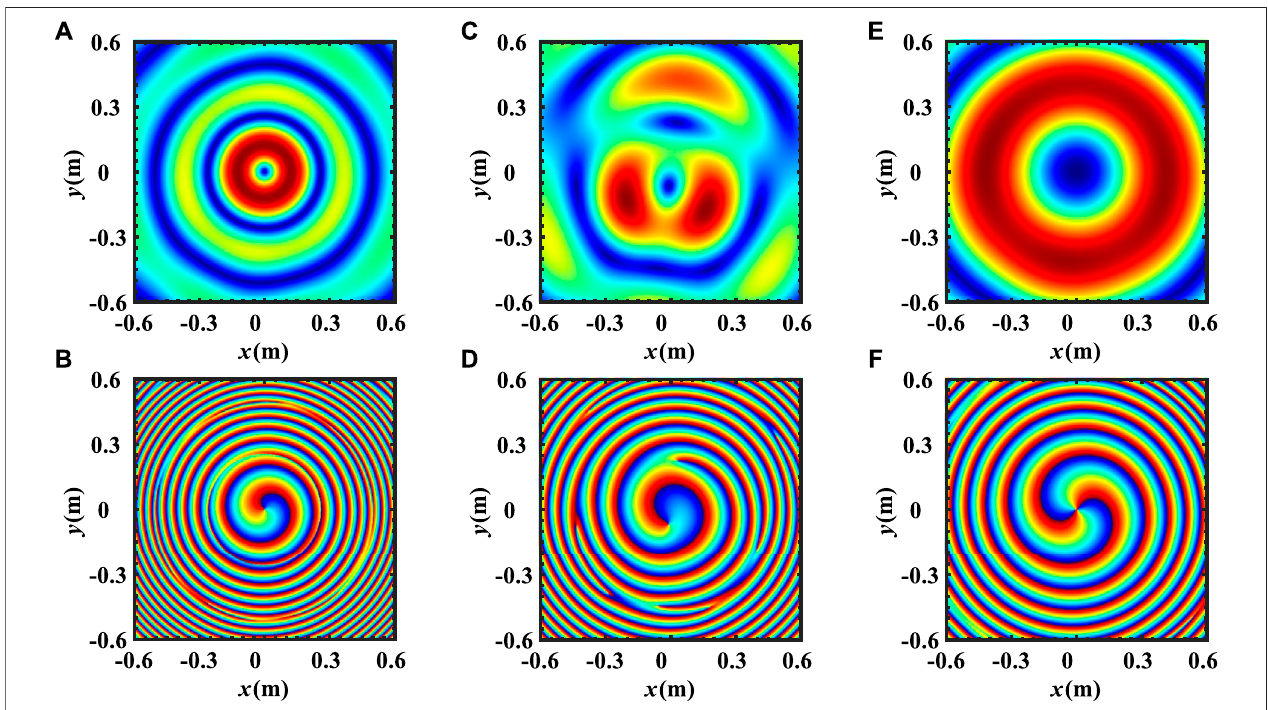
FIGURE5| Beam distributionandphasedistributionoftheCFDA-based OAMatobservationdistanceswhile t =0.3 μ s . (A) Beam distribution while z =1.25 m ; (B) phase distribution while z = 1.25 m ; (C) beam distribution while z = 1.875 m ; (D) phase distribution while z = 1.875 m ; (E) beam distribution while z = 2.5 m ; (F) phase distribution while z = 2.5 m .